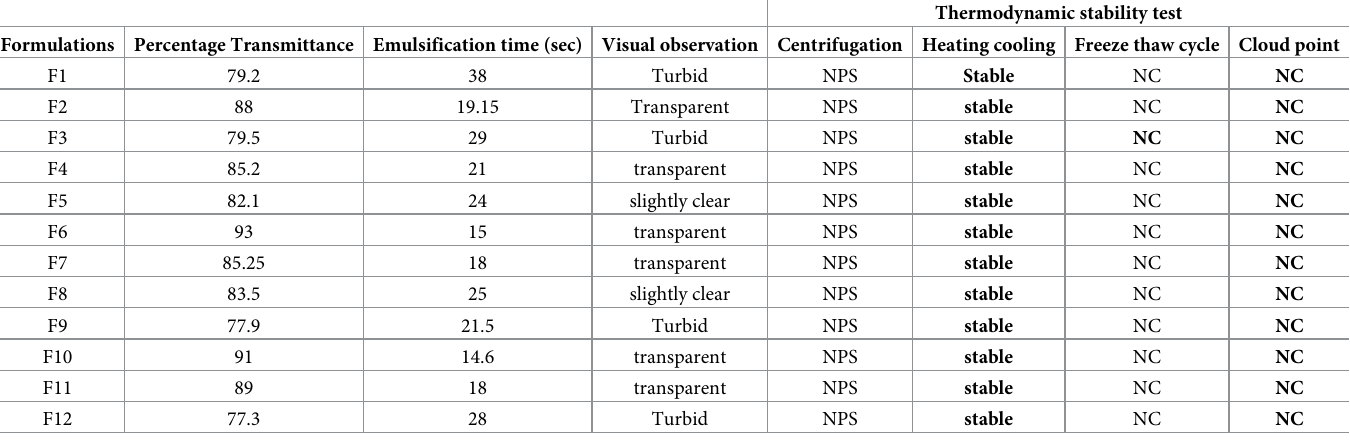
Table 2. Composition of SNEDDS containing Iodine with thermodynamic stability